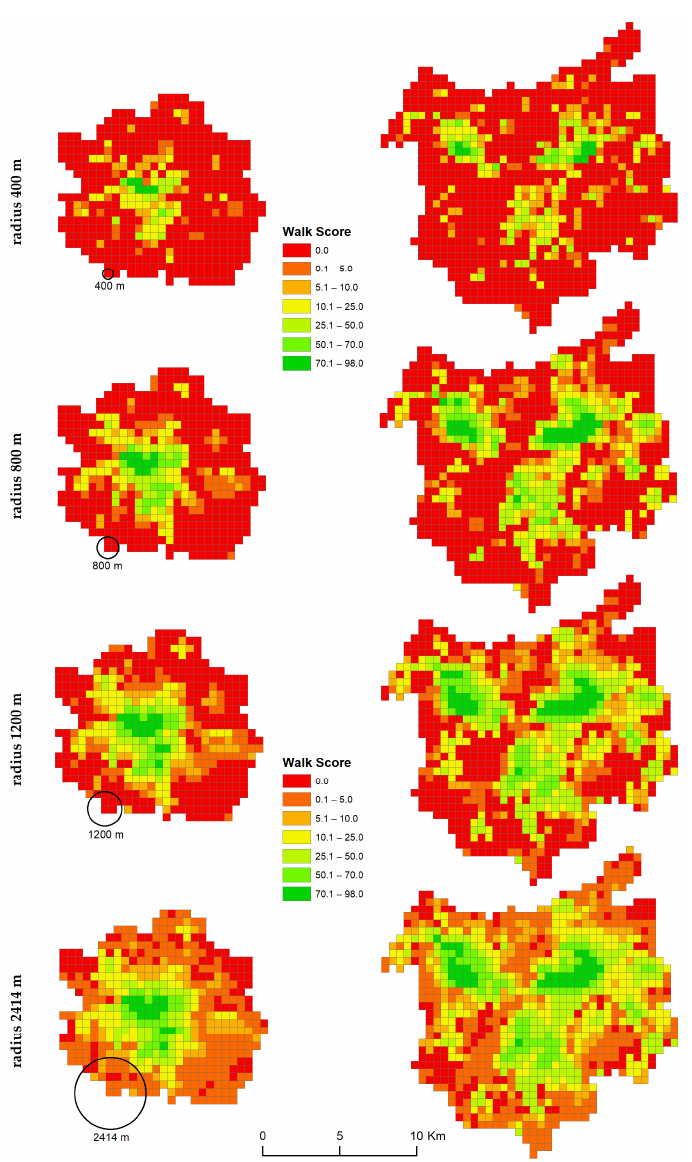
Figure 7. Standard WS for different buffers in Hradec Kralove ( left ) and Ostrava ( right ).